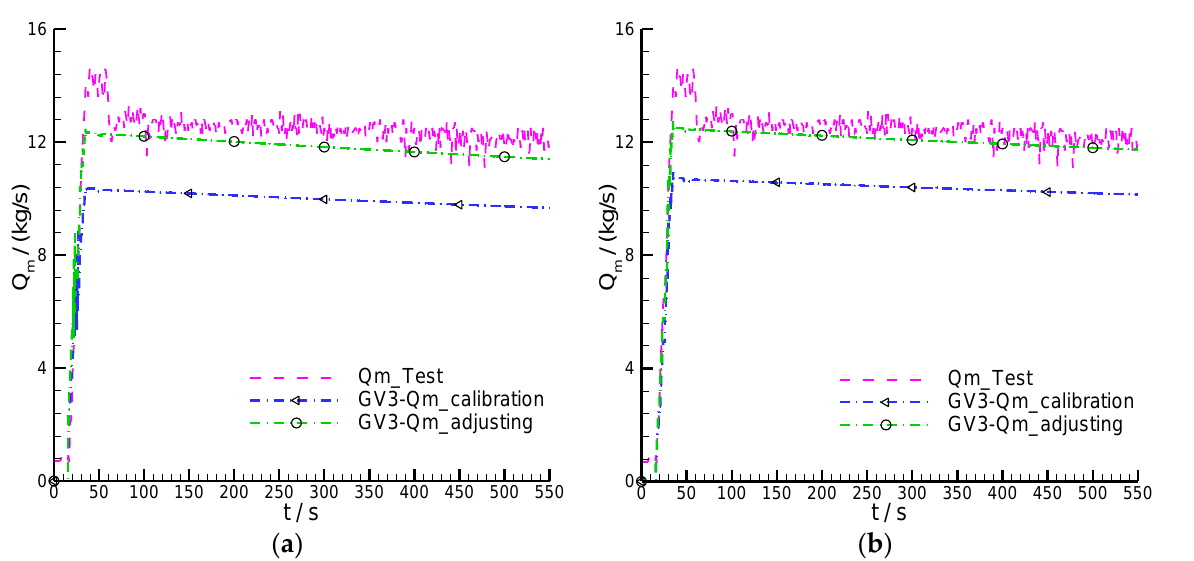
Figure 3. Comparison of mass-flow-rate calibration and adjusting simulation results of F3 selecting two reference-valve models with experimental measurements: ( a ) Vanessa 30,000 butterfly valve throttling model; ( b ) HCB cage-type regulator valve throttling model.